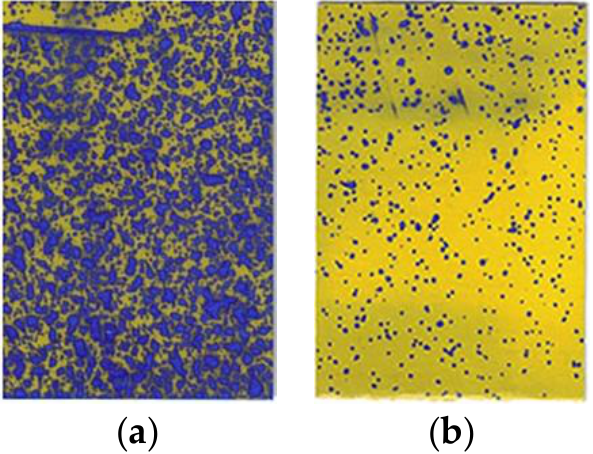
Figure 5. Example of spraying results. ( a ) adaxial surface; ( b ) abaxial surface.